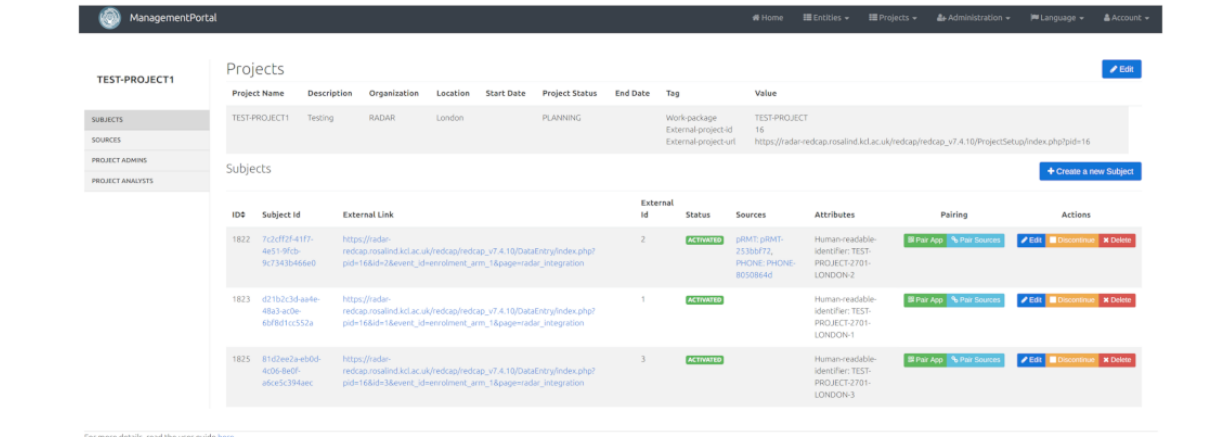
Figure 8. RADAR-base Management